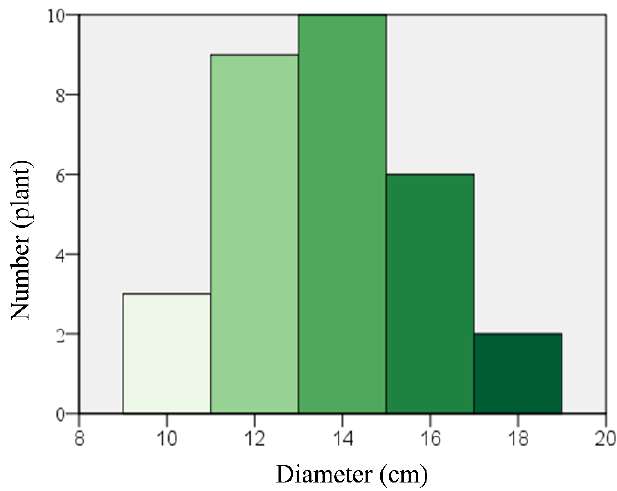
Figure 3. Diameter rank distribution.